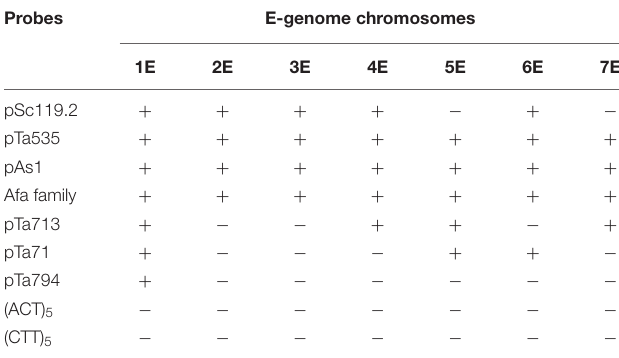
TABLE 3 | FISH identification of tetraploid Th.